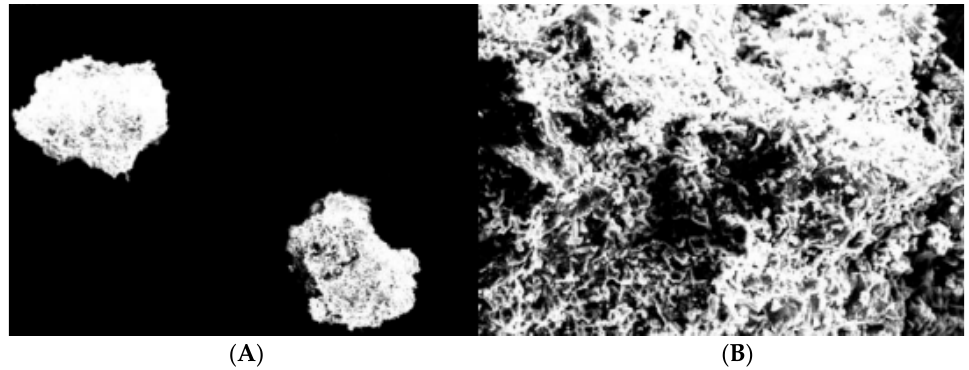
Figure 6. SEM images of ketoconazole inclusion complexes (×100, A ), (×500, B ).